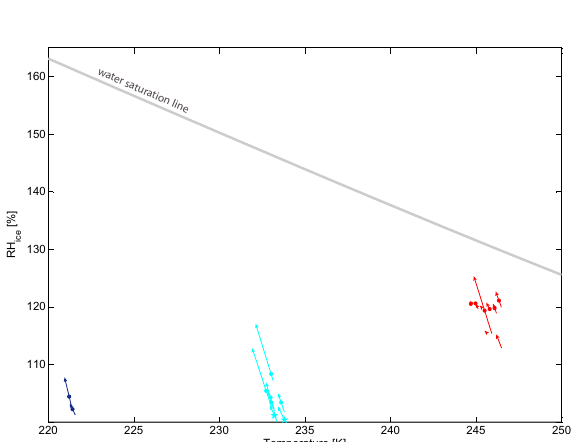
Figure 4. Trajectories of ice nucleation experiments with ice nu- cleation thresholds: trajectories are shown from the point when ice crystal concentrations first exceed background concentrations, with only the part being shown for which RH ice increases almost linearly with decreasing temperature; relative humidity over ice correspond- ing to an ice-active particle fraction f ice = 1% is indicated by • for standard experiments using cyclone impactors to define an aerosol size cutoff, and (cid:63) for experiments including larger particles.